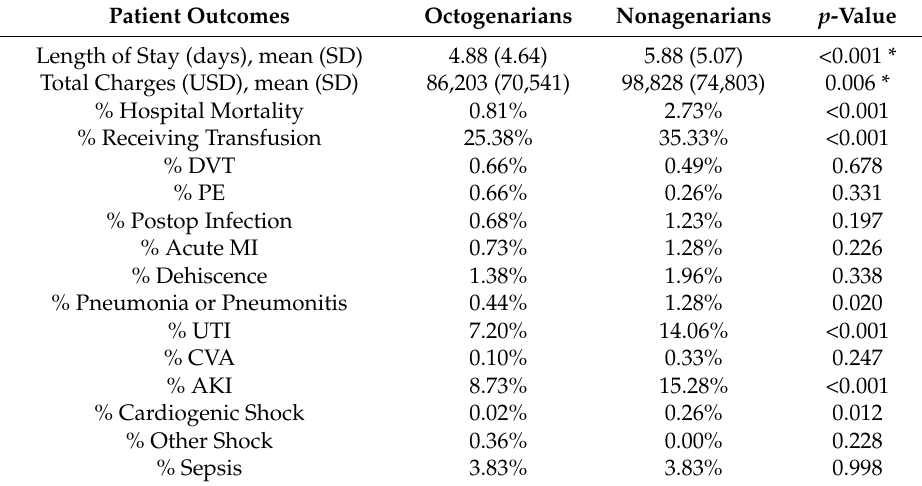
Table 4. Comparing outcomes and complications of patients undergoing revision total knee arthroplasty between octogenarians and nonagenarians. Healthcare Cost and Utilization Project—Nationwide Inpatient Sample,